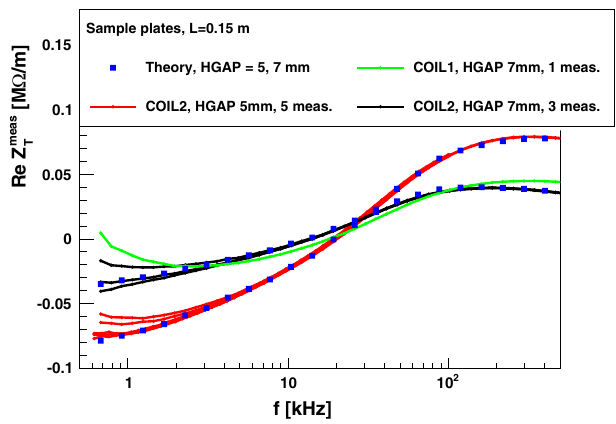
FIG. 13. (Color) Measurement results accuracy and reproduc- ibility using two different coils and two different gaps. The negative values for f < 20 kHz follow from Re ð Z ref Re ð Z DUT Þ at low frequencies, as discussed when defining W Eq.